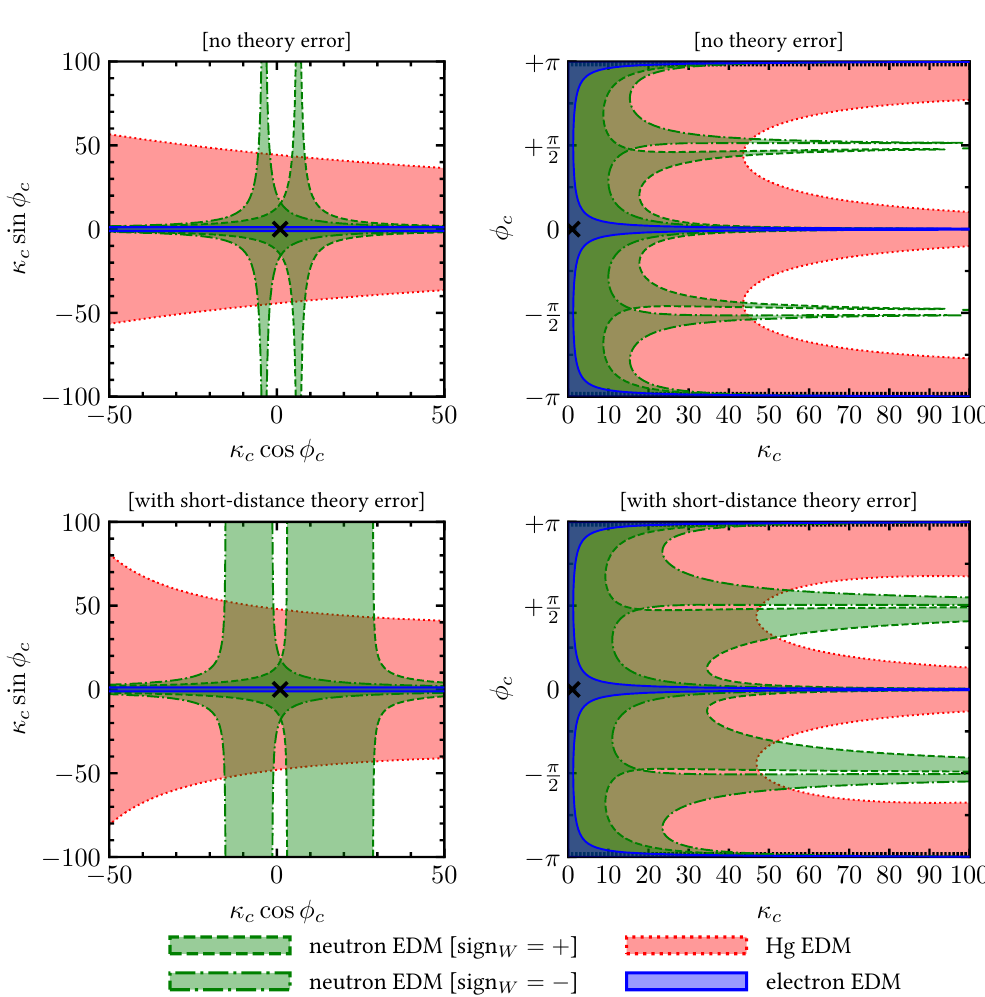
Figure 9 . The same as figure 8, but for the case of anomalous CP violating charm-quark